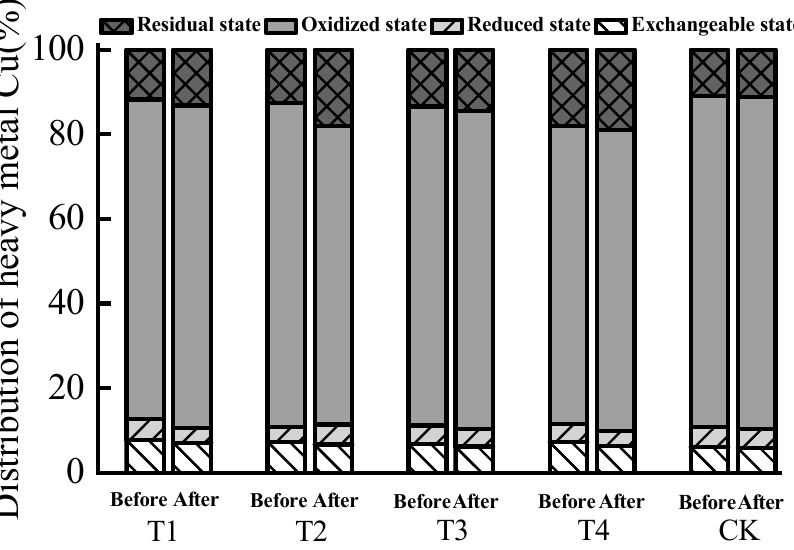
Figure 1. Distribution rate of various forms of Cu before and after biogas residue composting.